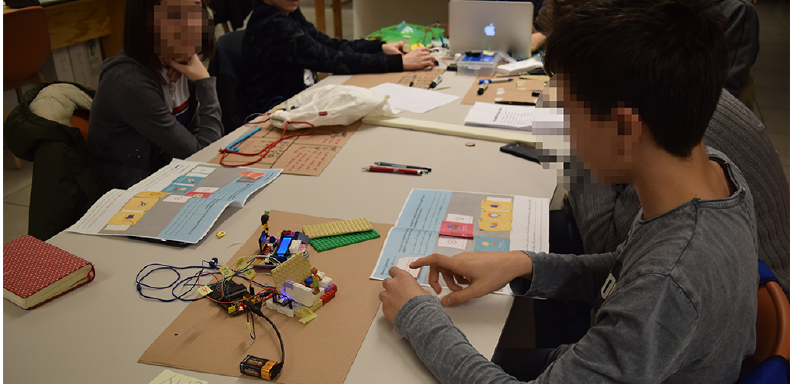
Figure 7. Children prototyping their smart objects in the in-presence workshop with the physical SNaP toolkit for school classrooms